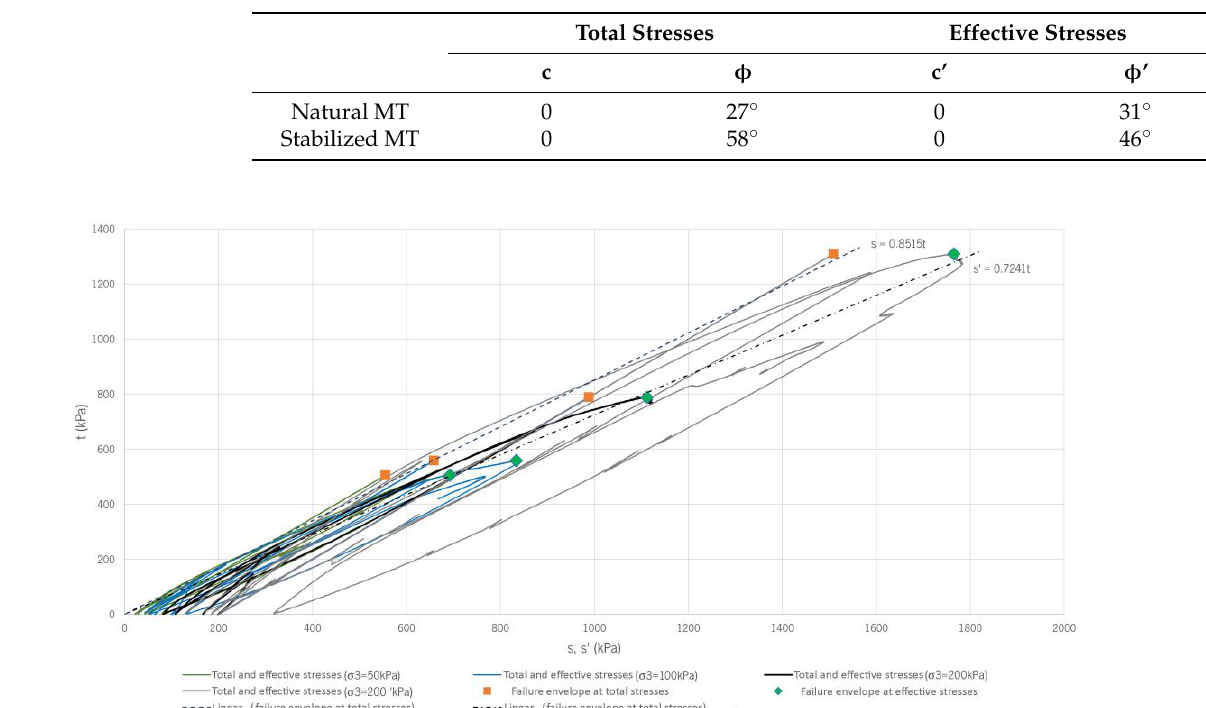
Figure 22. Failure envelopes of the mine tailing in peak deviatoric stresses (stabilized specimens). Table 7. Shear strength parameters of the mine tailing before and after stabilization (residual devi- atoric stresses).